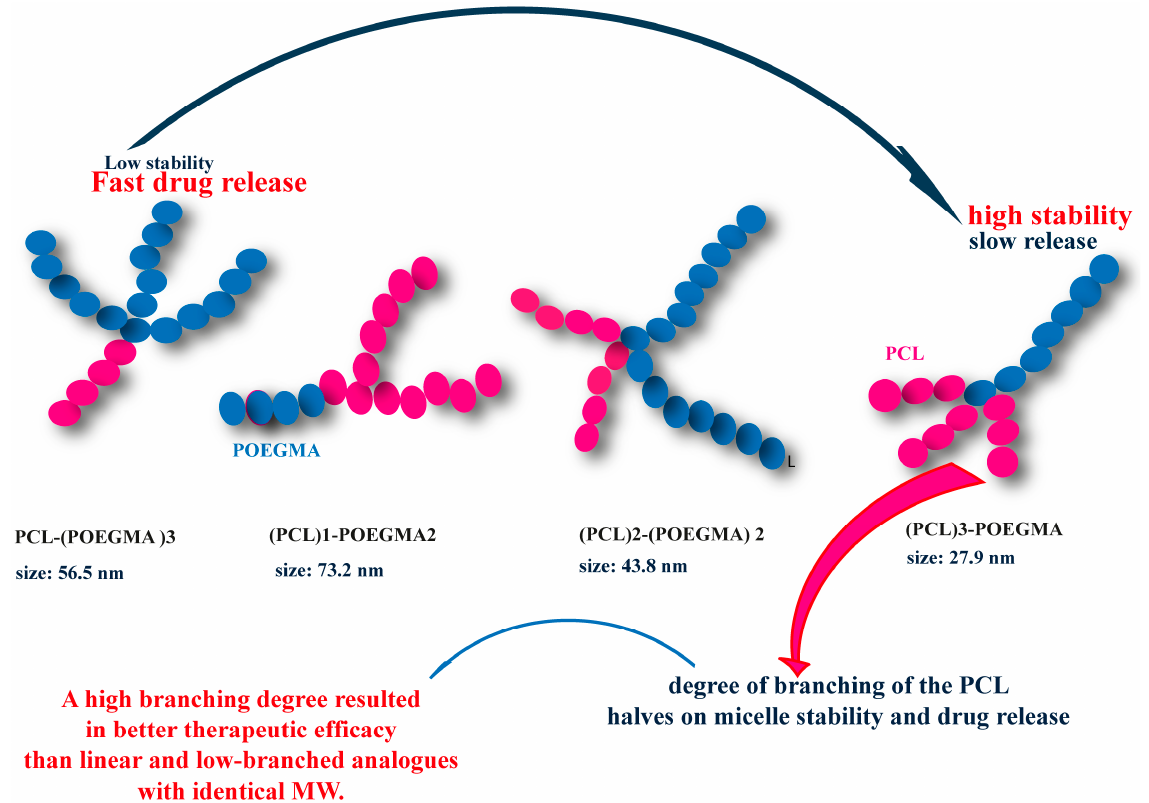
Figure 20. Structural Adaptation of Arm Number in Star-Shaped Copolymers (POEGMA-PCL) as a New Strategy for Designing Highly Effective Drug Delivery Carriers.